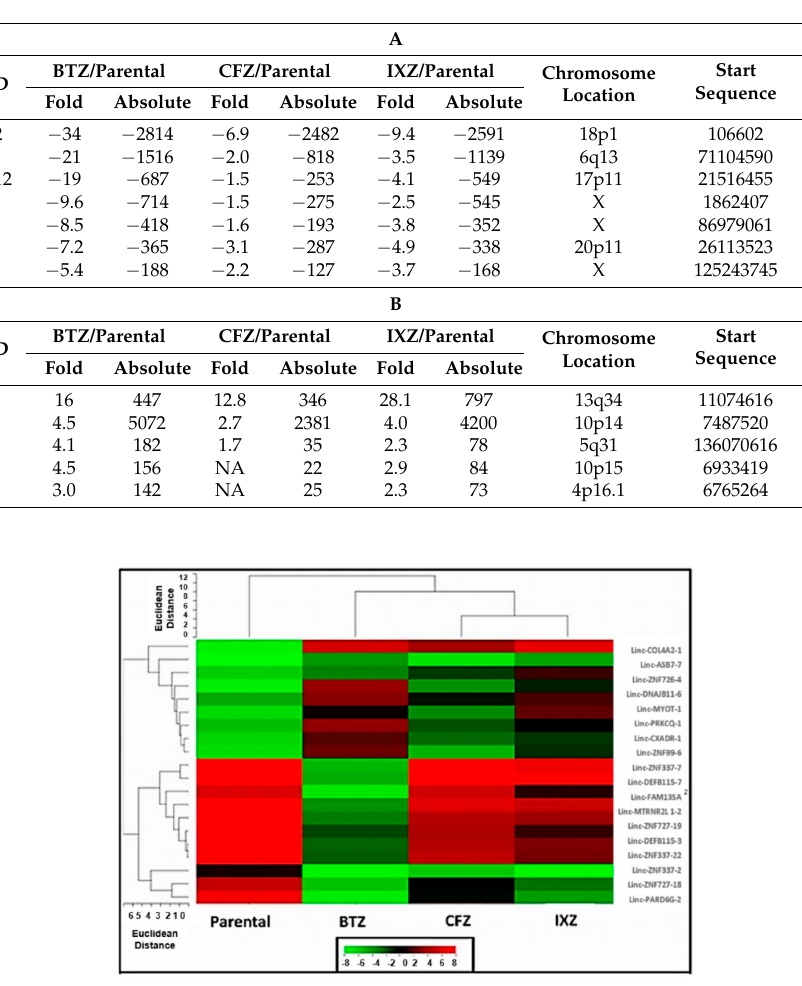
Table 2. Long non-coding RNAs (lncRNAs) down- or upregulated in bortezomib-, carfilzomib-, and ixazomib-resistant cells compared to drug-sensitive parental cells. Shown are individual lncRNAs either downregulated ( A ) or upregulated ( B ) in each PI-resistant RPMI8226 cell line compared to parental RPMI8226 cells. Values reflect the log fold-change or the absolute change in expression level in the resistant cells relative to parental cells. Shown also is the chromosomal location of each lncRNA as well as the start and stop sequence sites.